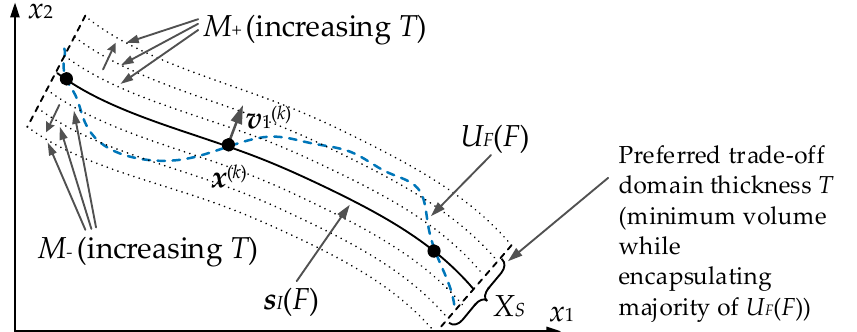
Figure 3. The meaning of the domain thickness parameter T , here, explained for two-dimensional parameter space. Increasing T enlarges the model domain which allows for encapsulating the optimum design manifold U F ( F ). At the same time, larger domain requires more training samples to render reliable surrogate. The desired trade-off is to find the minimum value of T enabling incorporation of the majority of U F ( F ) into X S .